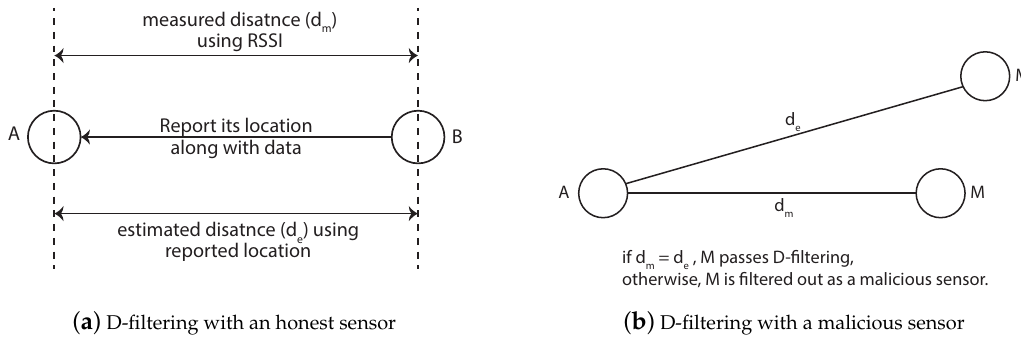
Figure 3. Distance-inconsistency filtering (D-filtering) ( a ) with an honest sensor and ( b ) with a malicious